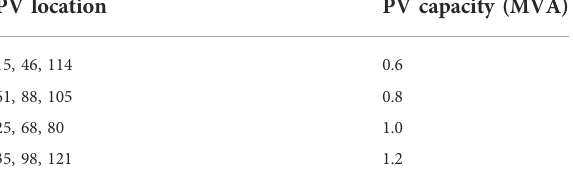
TABLE 1 Capacity and location of PV